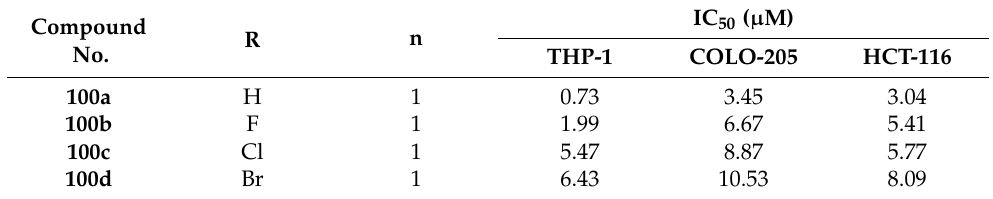
Figure 95. Structure of isatin-based coumarin derivatives ( 100 ). Table 85. In vitro cytotoxic activities of isatin ‐ based coumarin hybrid compounds 100 ( a – d ).